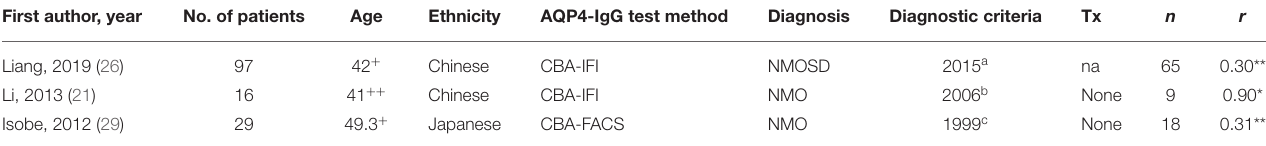
TABLE 3 | Studies included in the meta-analysis for the correlation between the serum AQP4-IgG titer and the Expanded Disability Status Scale (EDSS) score.